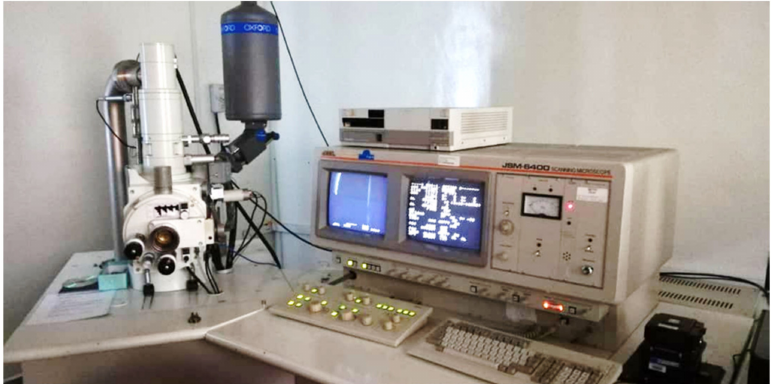
Figure 4. A scanning electron microscope